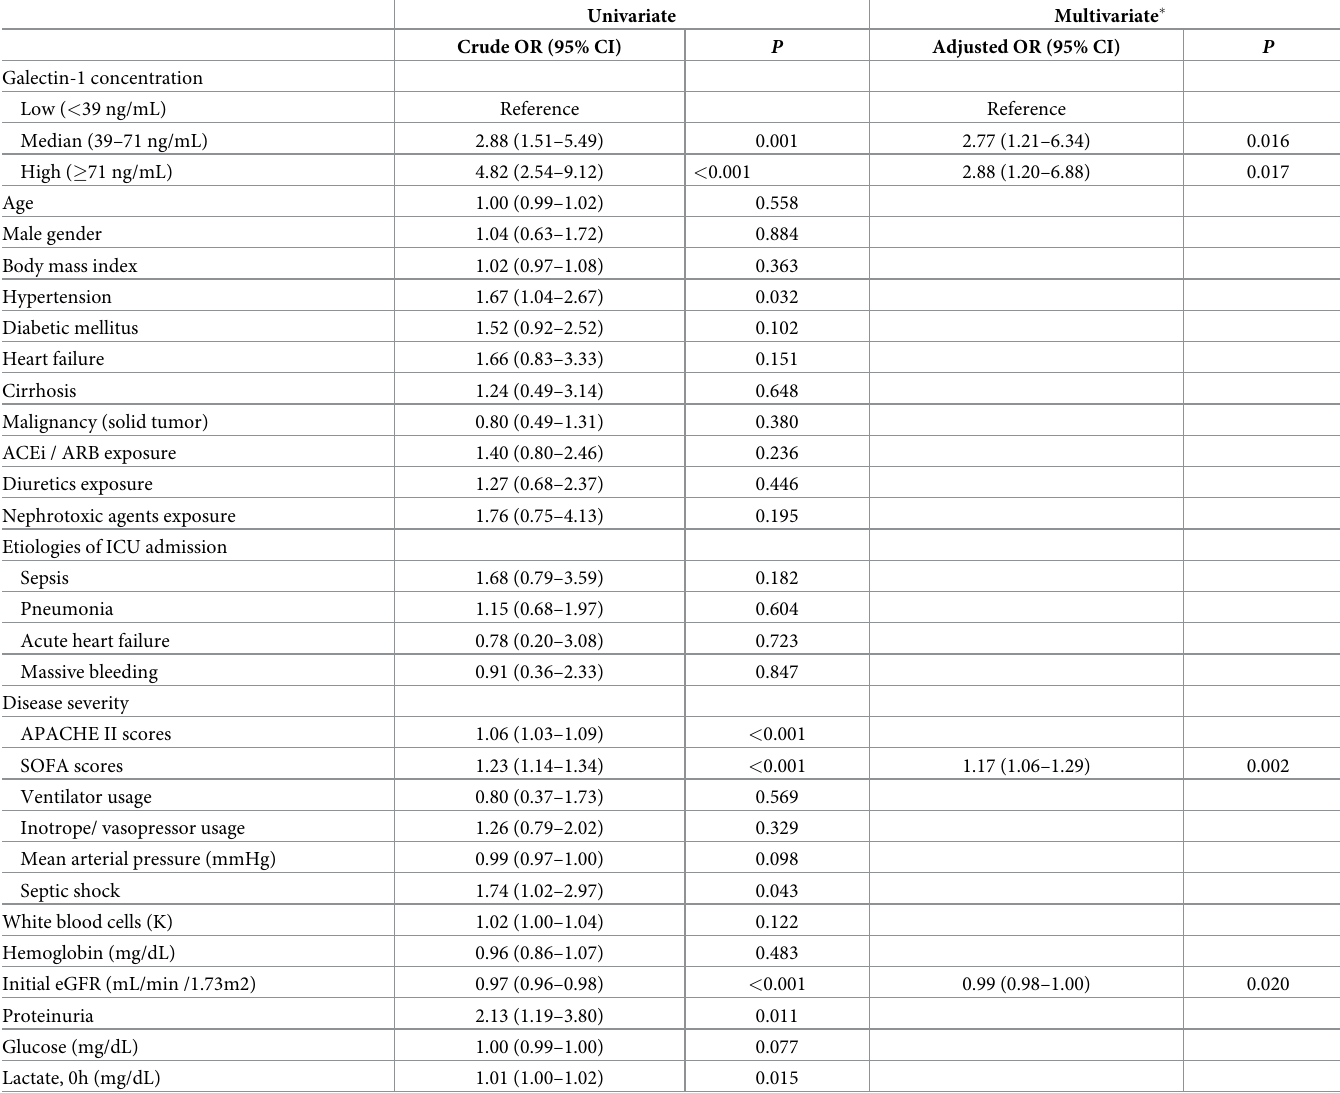
Table 5. Multivariate associations of the galectin-1 tertiles and factors with acute kidney injury within 48 h after intensive care unit admission (forward stepwise multivariate regression